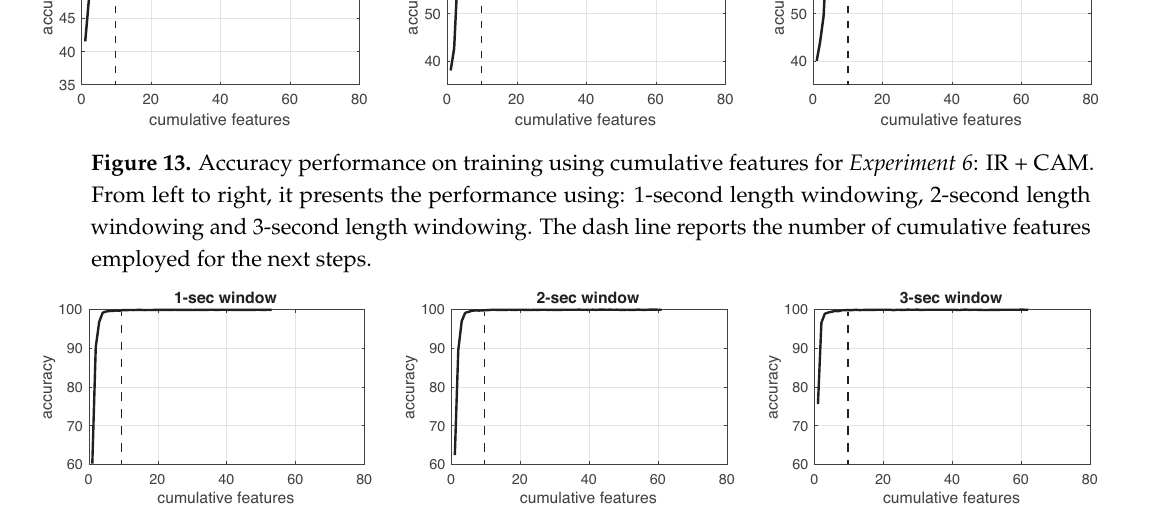
Figure 14. Accuracy performance on training using cumulative features for Experiment 7 : IMU + EEG + CAM. From left to right, it presents the performance using: 1-second length windowing, 2-second length windowing and 3-second length windowing. The dash line reports the number of cumulative features employed for the next